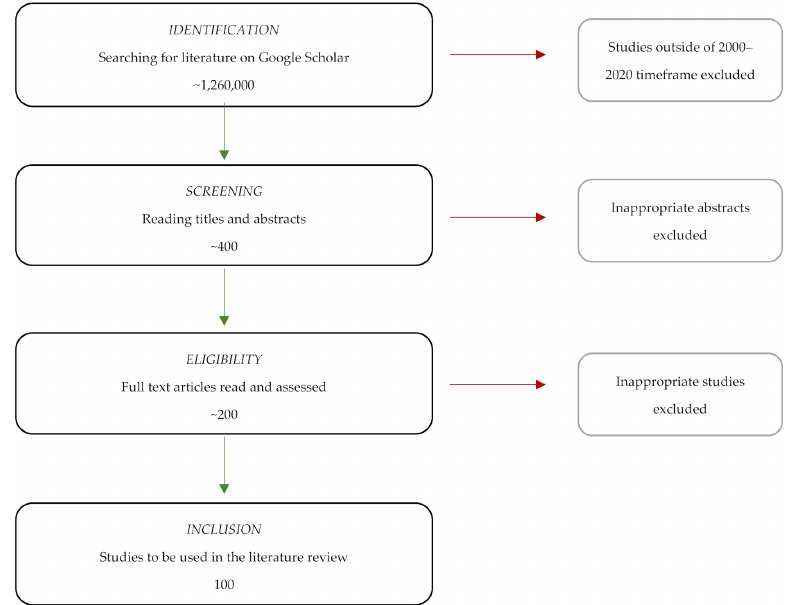
Figure 1. Literature review methodology